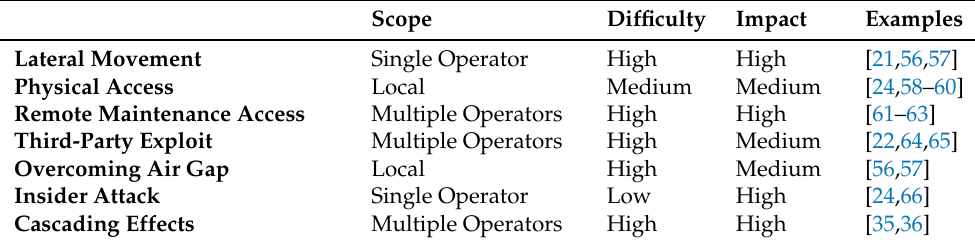
Table 1. Classification of attack vectors specific for the energy